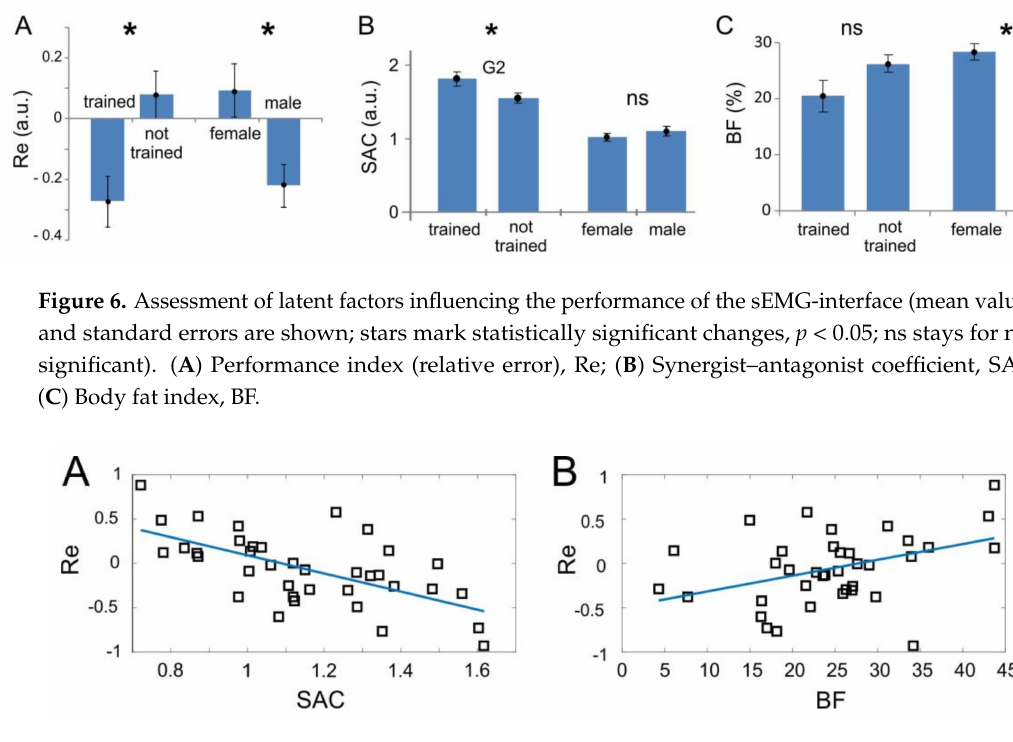
Figure 7. Performance of the sEMG-interface as a function of latent factors: ( A ) The synergist– antagonist coefficient (SAC) and ( B ) body fat index (BF) (squares). In both cases, there is a significant correlation. Blue lines represent linear regressions ( p = 0.001 and p = 0.01 for ( A ) and ( B ),